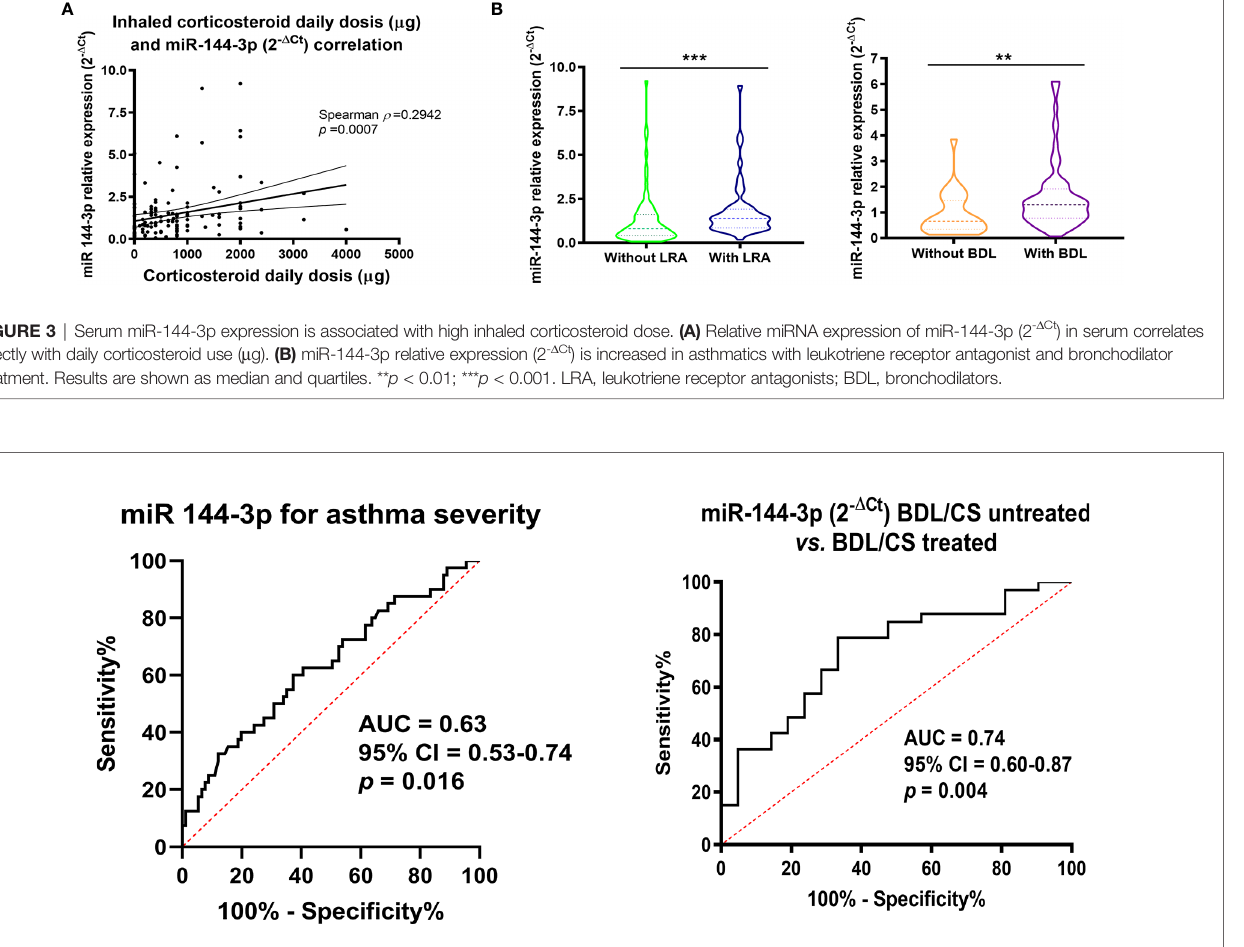
FIGURE 4 | MiR-144-3p expression in serum is a biomarker for severe asthma and corticosteroid plus bronchodilator treatment. CS, corticosteroids; BDL, bronchodilators; AUC, area under the curve; CI, con fi dence